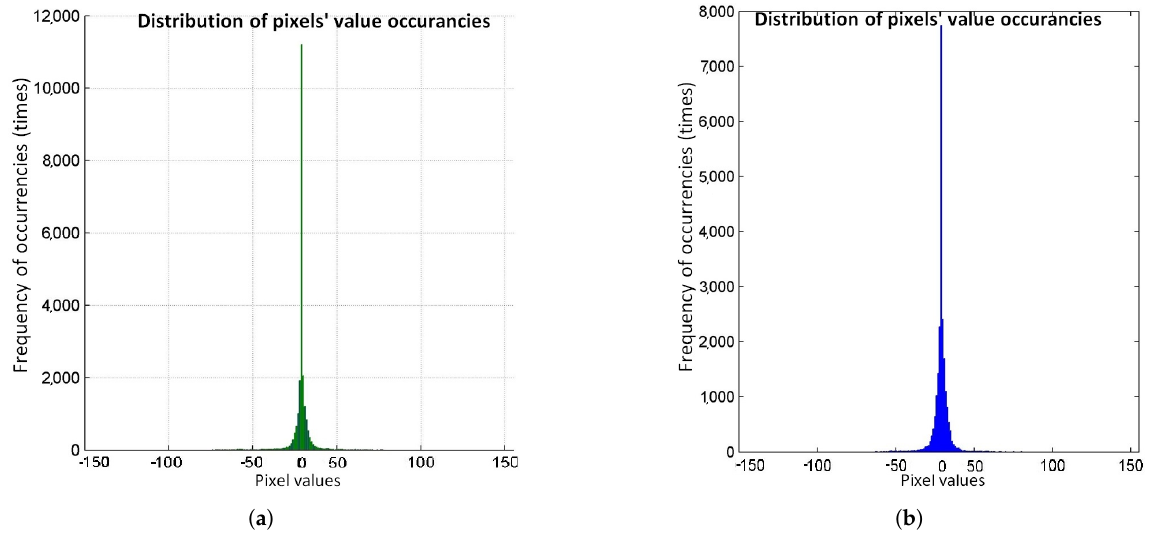
Figure 5. Green and Blue planes statistics after DPCM coding. ( a ) Statistical distribution of colour values for Green colour plane; ( b ) Statistical distribution of colour values for Blue colour